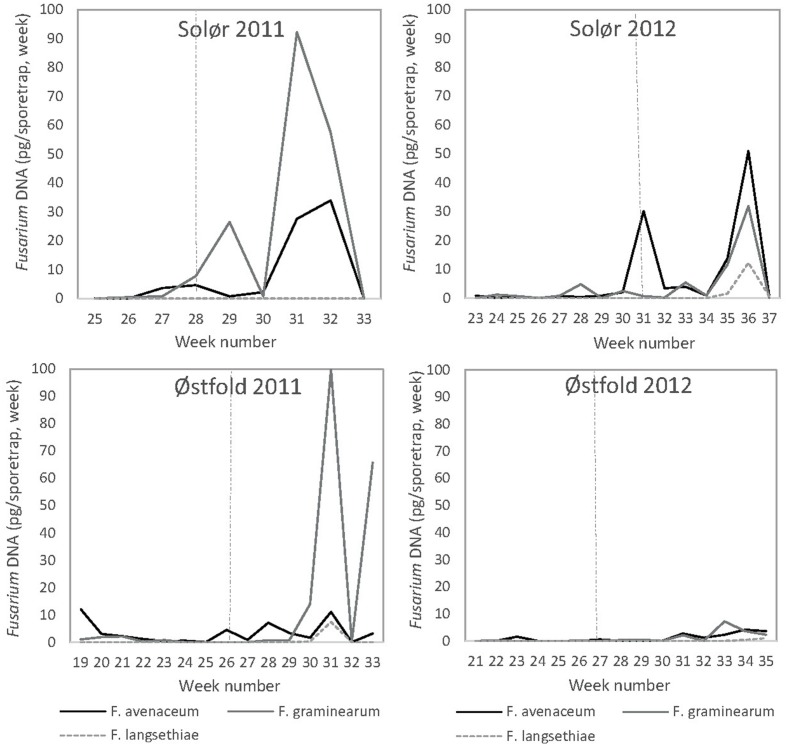
The weekly average DNA amounts (pg) of F. avenaceum, F. graminearum, and F. langsethiae recorded in spore-traps located in oat trials at two locations in southeast Norway (Solør and Østfold) in 2011 and 2012.
Fusarium DNA was quantified by qPCR. Stippled lines indicate the timing (given as the week) of oat heading.